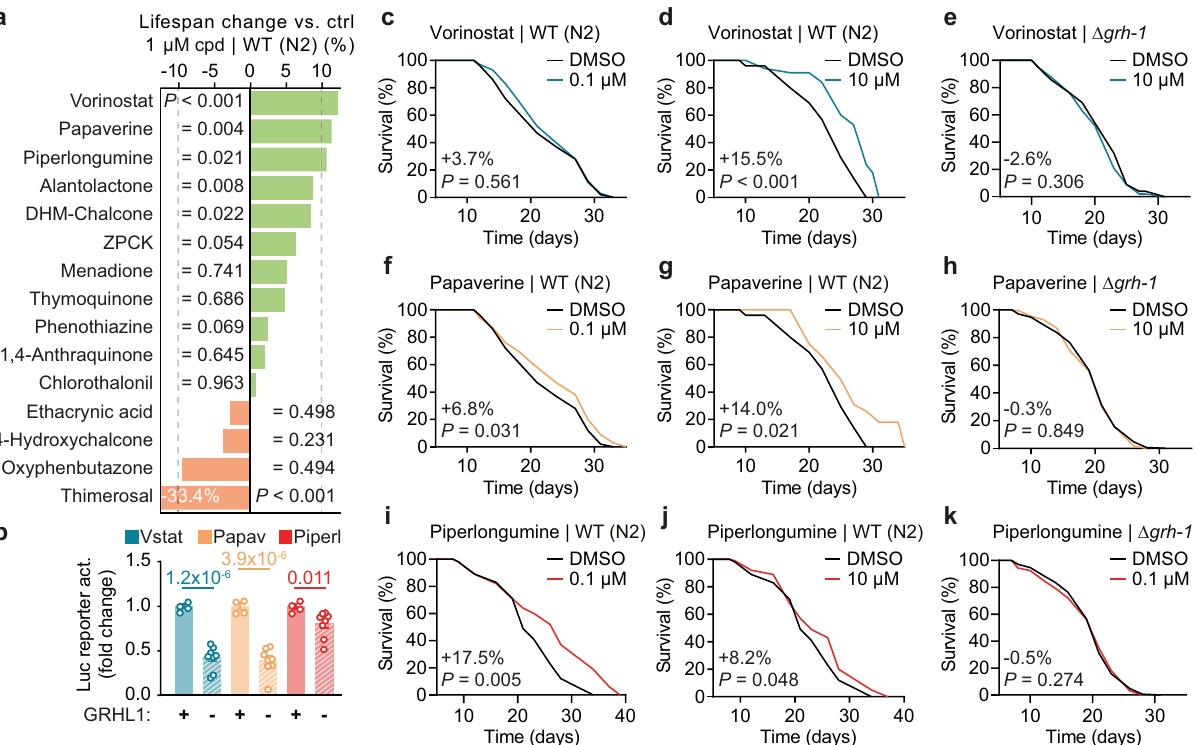
Fig. 3 GRH-1 dependency of nematodal lifespan-extension elicited by selected GRHL1-activating compounds. a Overview of impact of the respective compound (cpd) on lifespan of wild-type (WT) N2 nematodes at 1 µ M in plate, as percentage change of mean lifespan vs. control treatment with DMSO (ctrl). Also see Fig. 2c – q. b Activation of GRHL reporter by the top 3 lifespan-extending compounds from ( a ) (Vstat = vorinostat, Papav = papaverine, Piperl = piperlongumine) at 5 – 10 µ M in the presence (wild-type reporter with n = 4) or absence (two independent deletion reporters with n = 8 combined) of GRHL1. c , d Lifespan assays of vorinostat at 0.1 ( c ) or 10 µ M ( d ) in plate, using WT (N2) nematodes and vs. DMSO control. e Lifespan assay of vorinostat at 10 µ M in plate, using Δ grh-1 and vs. DMSO control. f , g Similar to ( c ), ( d ), using papaverine. h Similar to ( e ), using papaverine at 10 µ M in plate. i , j Similar to ( c ), ( d ), using piperlongumine. k Similar to ( e ), using piperlongumine at 0.1 µ M in plate. Data in bar graphs are mean ± SEM, with sample sizes as stated and individual data points representing biological replicates. P -values were determined with two-tailed unequal variances t -tests of the indicated comparisons of unpaired control vs. treatment groups. Lifespan graphs contain percentage change of mean lifespan compound vs. DMSO control and P -values as determined by log-rank test. See Supplementary Data 1 for detailed lifespan assay statistics. Source data are provided as a Source data fi